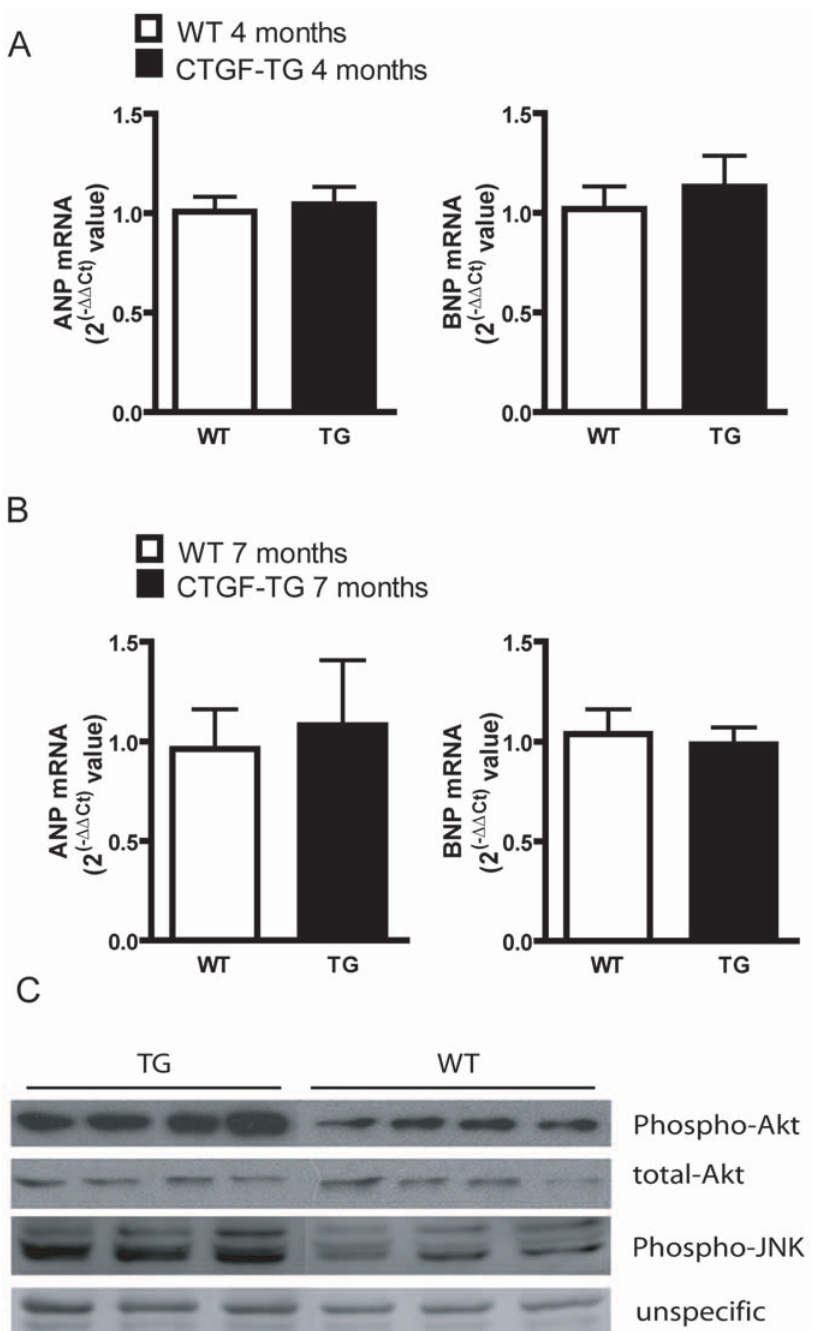
Figure 4. Quantification of expression and activation of cardiac hypertrophy markers. (A, B) Quantification of ANP and BNP mRNA expression by TaqMan-PCR in 4- (A) and 7 months (B) old mice (n=4 per group). (C) Quantitative analysis of the phosphorylation status of Akt